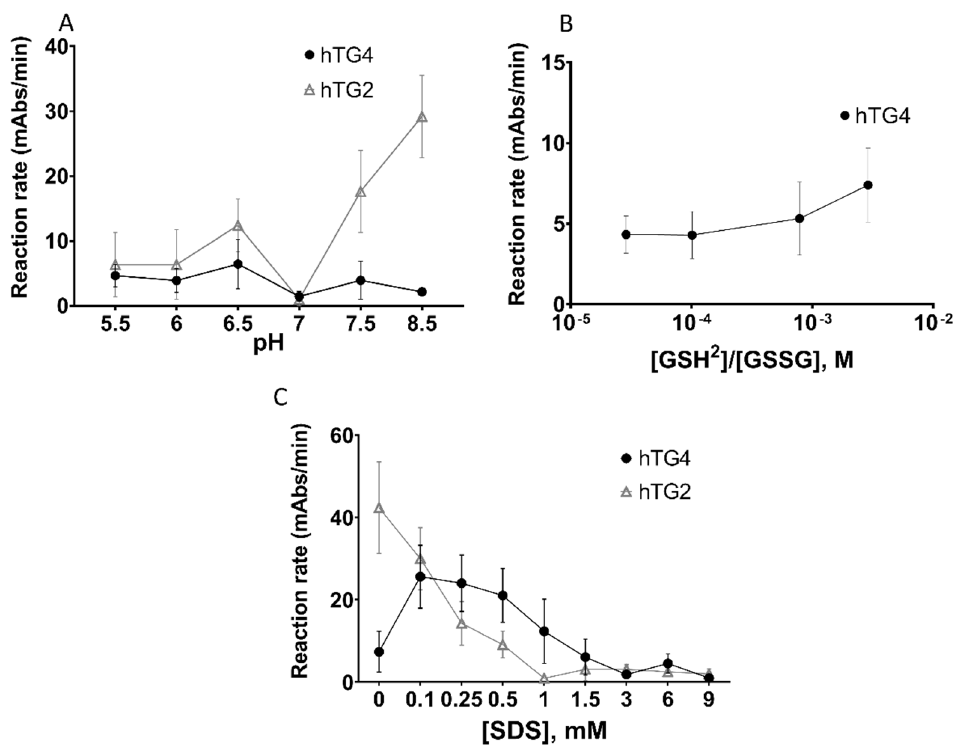
Figure 2. Effect of pH, reducing or oxidising environment, and sodium-dodecyl sulphate on hTG4 transamidase activity. The pH dependence of hTG4 and hTG2 transamidase activities between 5.5 and 8.5 pH ( A ). Effect of redox conditions on hTG4 transamidase activity ( B ). To observe the